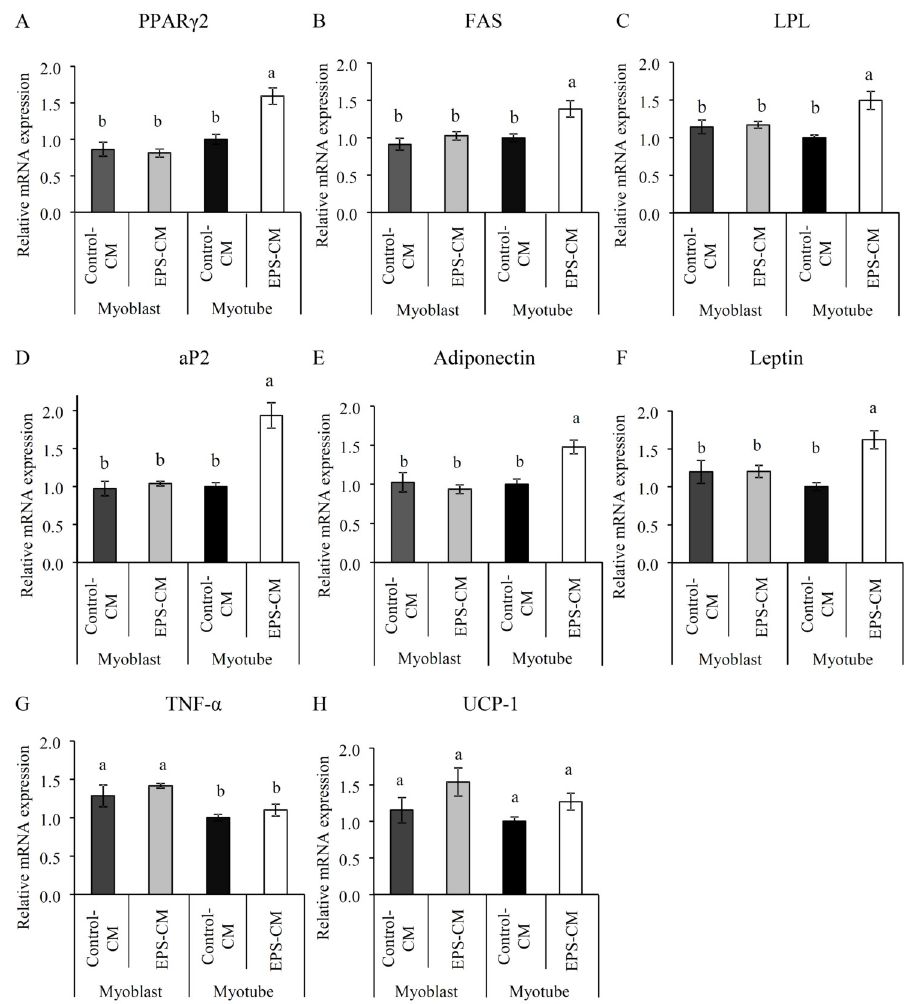
Fig 5. Effects of myotube EPS-CM treatment on mRNA expression of 3T3-L1 adipocytes. The mRNA expression level of 3T3-L1 adipocytes subjected to continuous treatment with C2C12 myotube/myoblast derived CM with and without EPS (EPS-CM and Control-CM) were measured on day 10 post-differentiation. (A-H) The expression levels of PPAR γ 2, FAS, LPL, aP2, adiponectin, leptin, TNF- α , and UCP-1 were evaluated by qRT-PCR. Data are expressed as mean ± SEM (n = 4–6). Different letters represent significant differences (p <